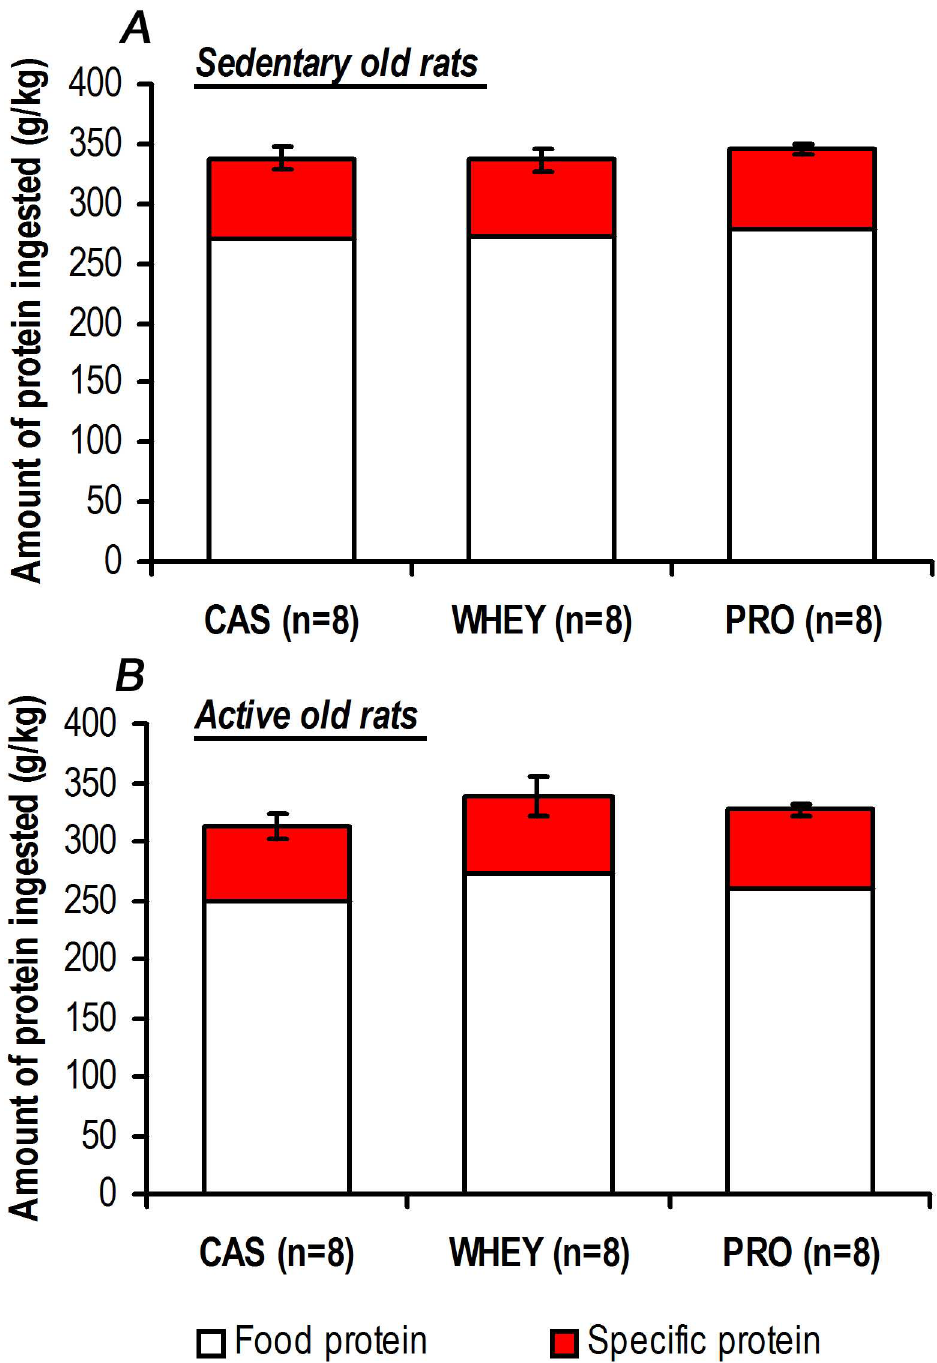
Fig 3. Similar total amount of protein ingested during study in sedentary or active old rats. For each sedentary ( A ) and active ( B ) rats, the weekly protein intake was calculated, normalizedto body weight and summarized to comparethe total amount of protein ingestedduringthe 2 months of the supplementation with casein, whey or solublemilk protein. With or without a low physicalactivity, the total amount of protein intake duringthe 2 months was not significantly different betweenspecific proteins. Values are means ±